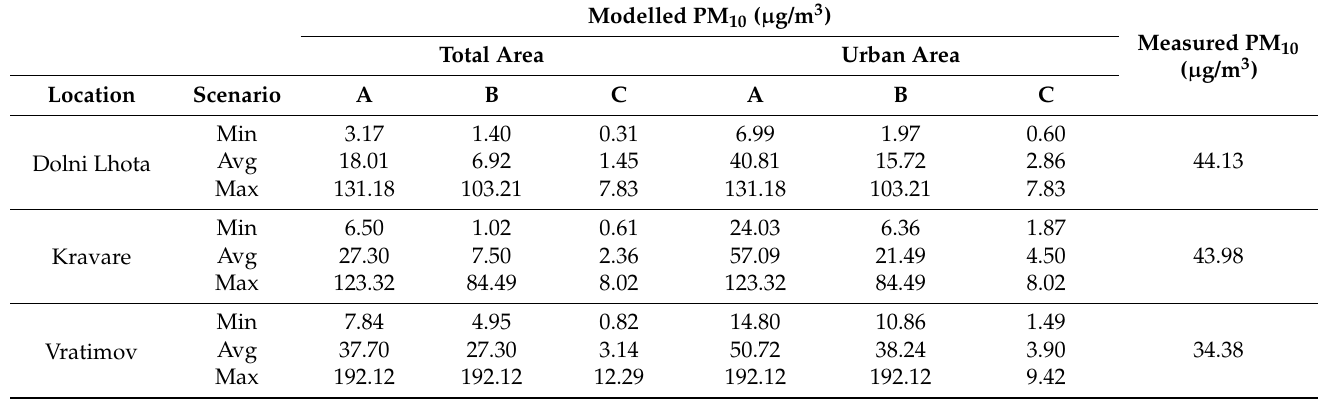
Table 3. Minimum, average and maximum daily concentrations of PM 10 for all three model scenarios and measured average concentrations.